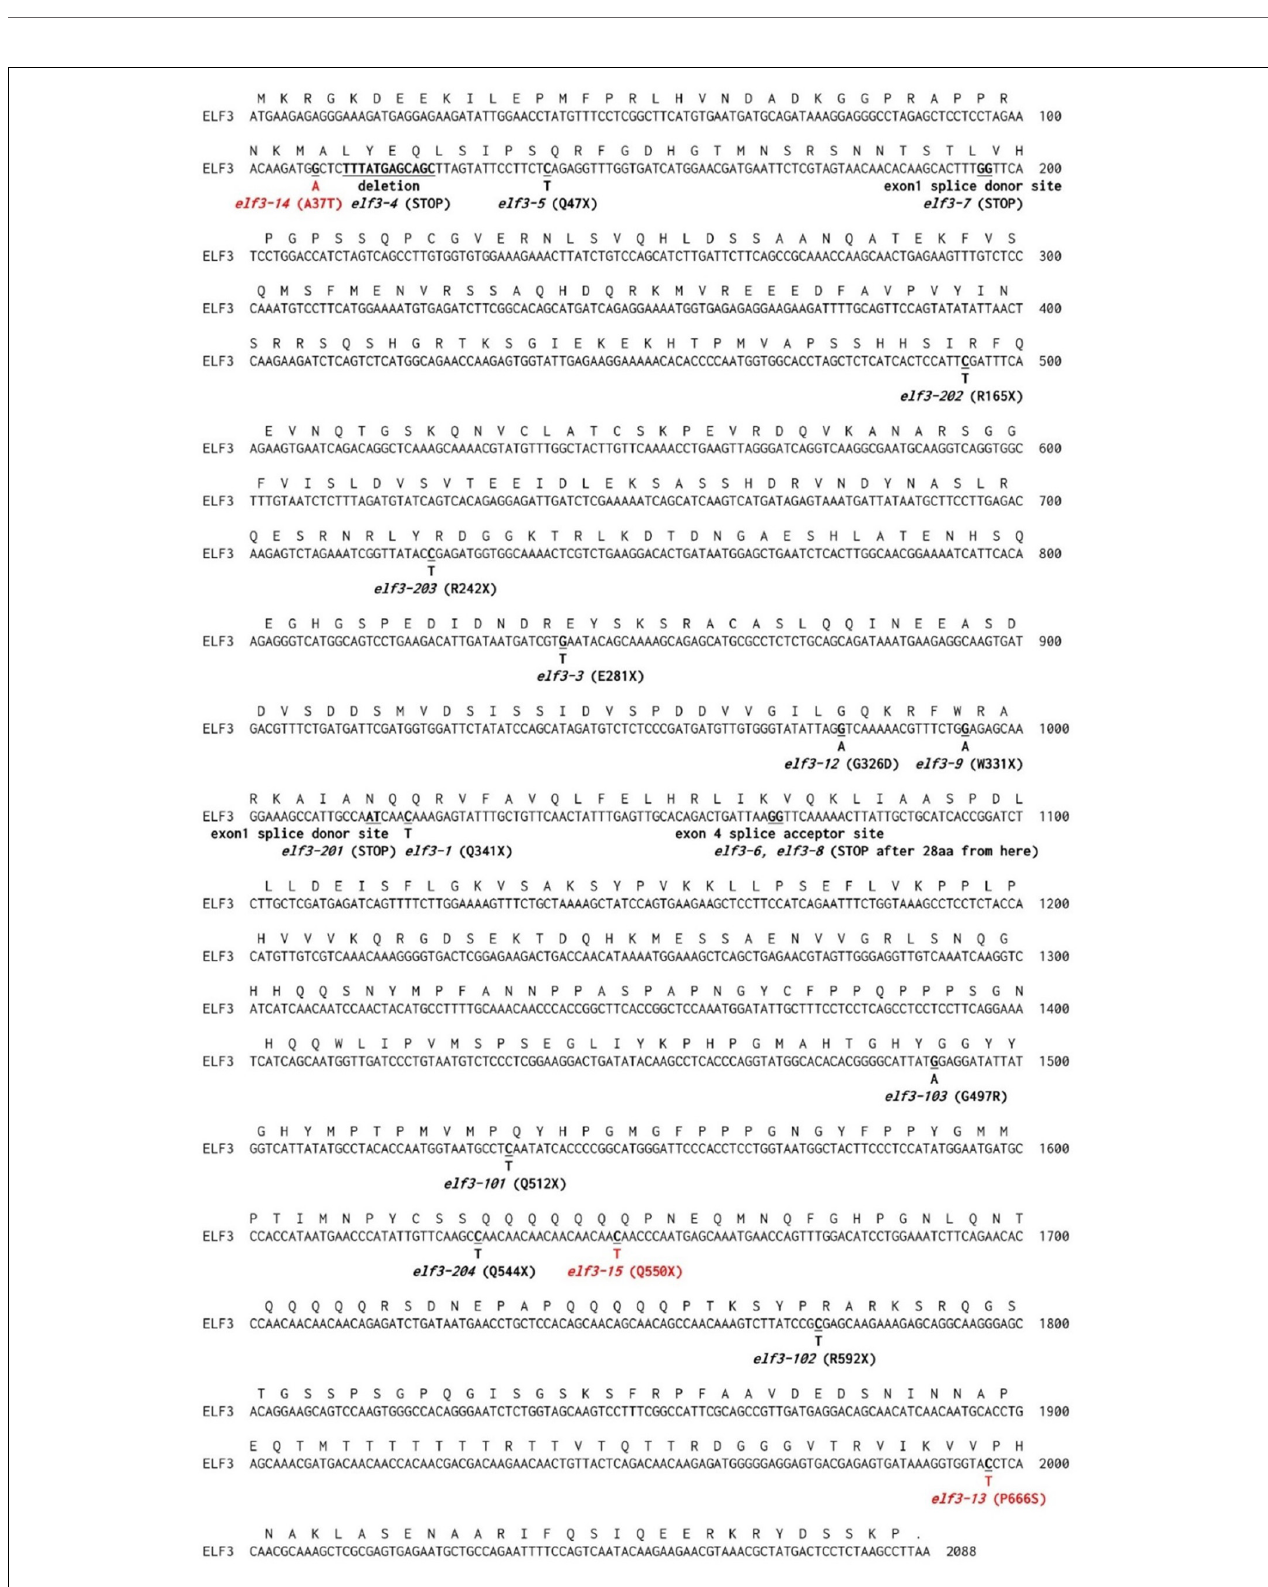
FIGURE 3 | Protein coding sequence of ELF3 . Deduced amino acid sequences and nucleotide changes in known elf3 alleles are shown above and below the nucleotide sequence. Sites of novel mutants identified in this study are indicated in red. Sources for the known indicated elf3 alleles are: elf3-1 , elf3-3 , elf3-4 , elf3-5 , elf3-6 , elf3-7 , elf3-8 , and elf3-9 (Hicks et al., 2001); elf3-12 (Kolmos et al., 2011); elf3-101 , elf3-102 , and elf3-103 (Yoshida et al., 2009); and elf3-201 , elf3-202 , elf3-203 , and elf3-204 (Kinoshita et al., 2011).